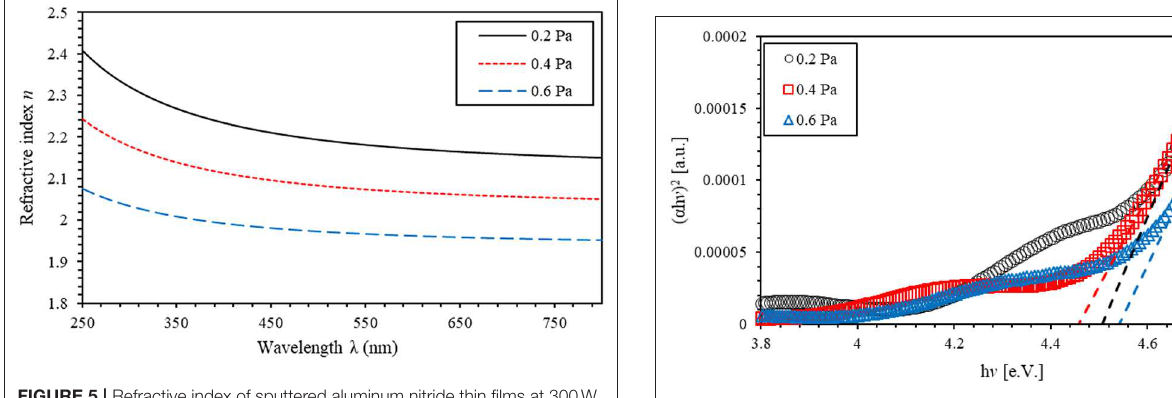
FIGURE 6 | Tauc optical band gap energy of sputtered aluminum nitride thin films at 300W and with different back pressures (0.2, 0.4, and